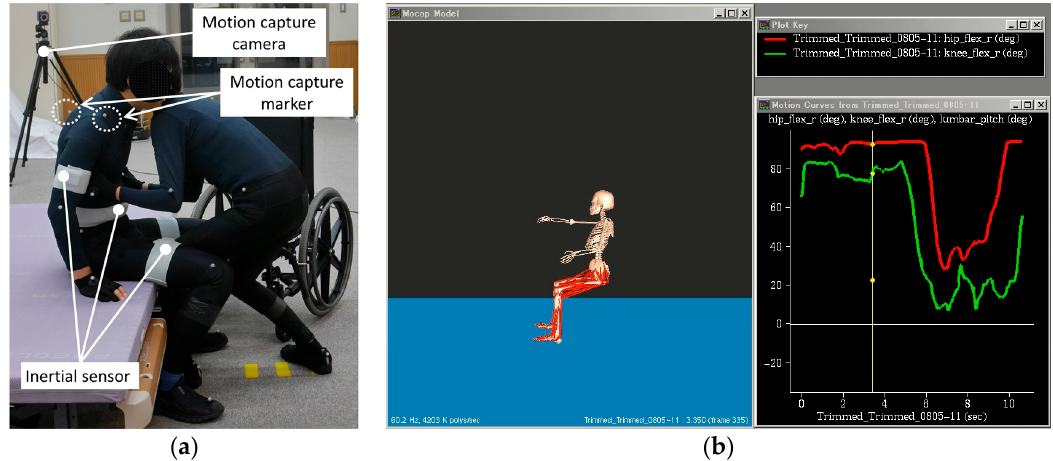
Figure 5. Illustration of the experiment ( a ) transfer trial ( b ) computation of joint angle of SIMM. Table 2. Translational acceleration in translational acceleration of patient.